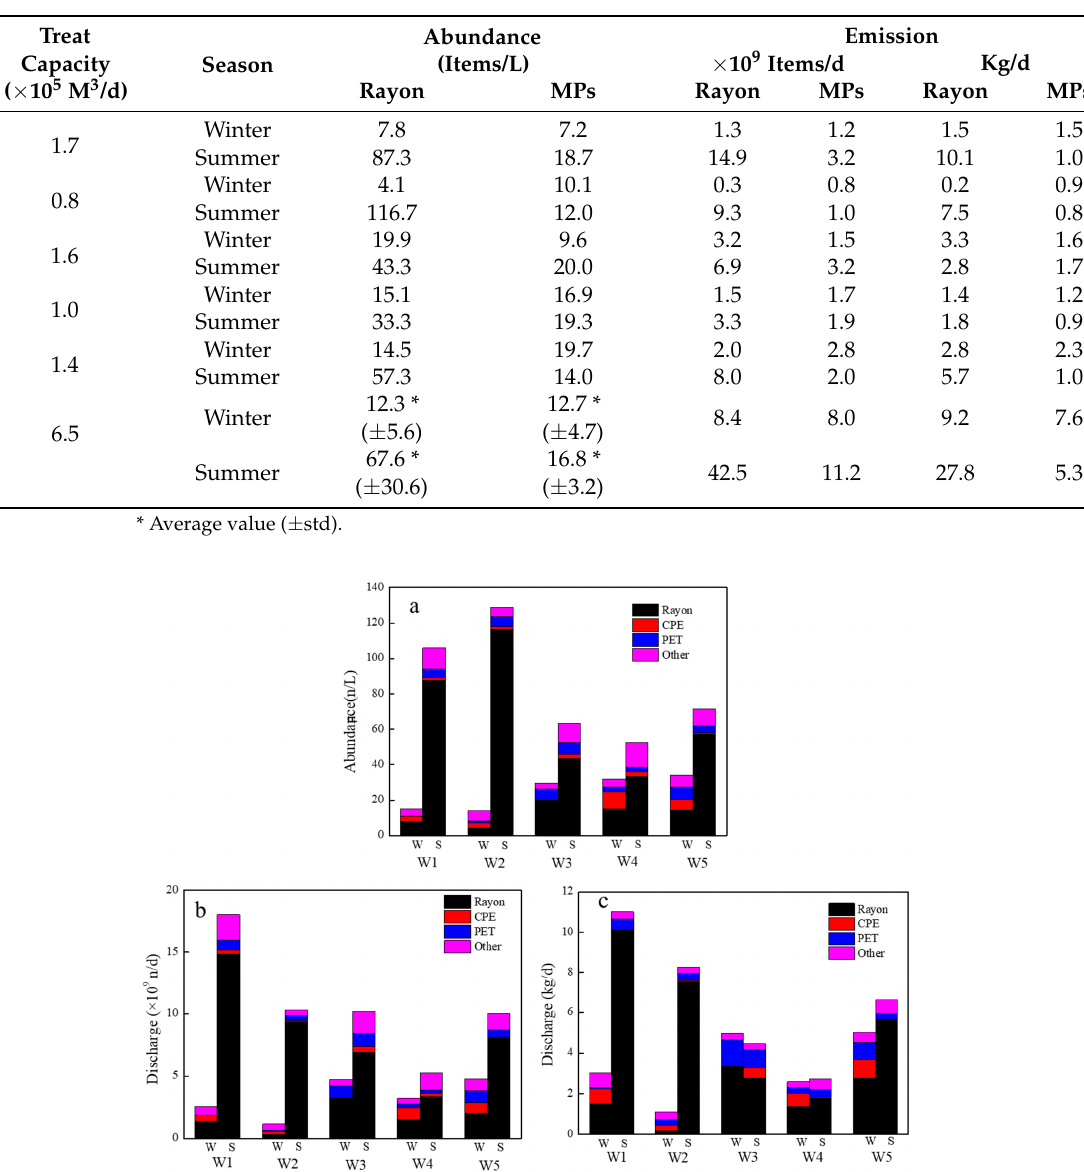
Table 1. The abundance in the effluent and the emission of rayon and the other polymer type MPs with the effluent from WWTPs in Qingdao, China.